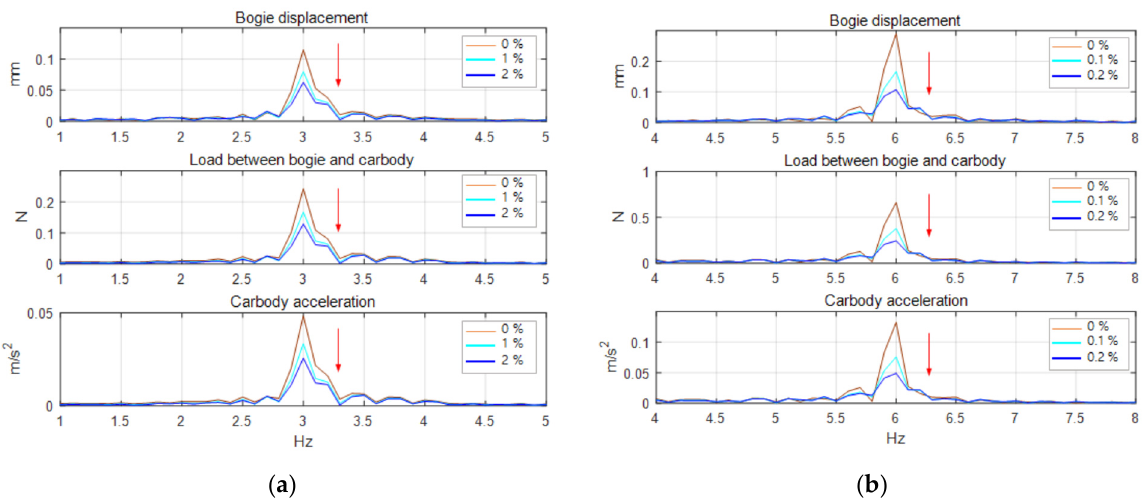
Figure 10. Effect of damping element on the vibration amplitude: ( a ) vertical direction, ( b ) lateral direction.